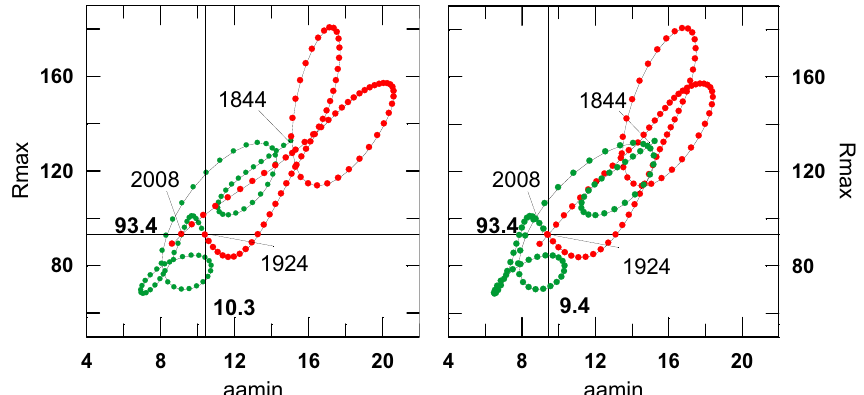
Fig. 5. The phase diagram gives one point per year for the period 1844–2011. The left-hand diagram is for the standard data; the other is for the Lockwood data. Data prior to 1968 are from Nevanlinna & Kataja (1993) in the two panels. From 1968 onward the aa min data are as given in Figure 2. The abscissa and ordinate of the horizontal and vertical lines are the coordinates of the Transition Point. There is a difference between the value of the ordinate of the Transition Point for the standard data (left) as compared with that derived with the Lockwood data.